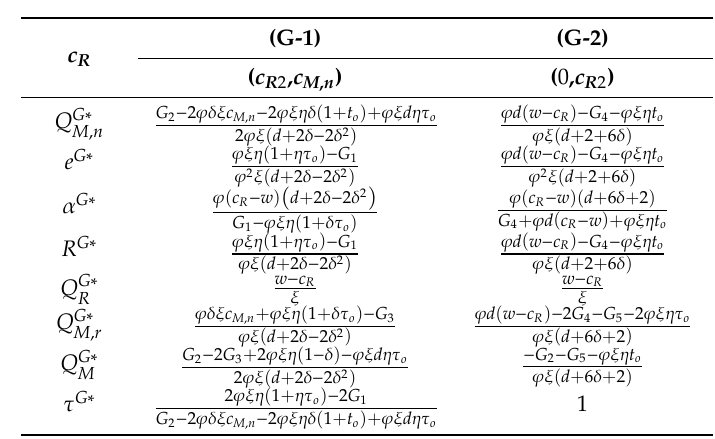
Table 4. Solution results for model G.